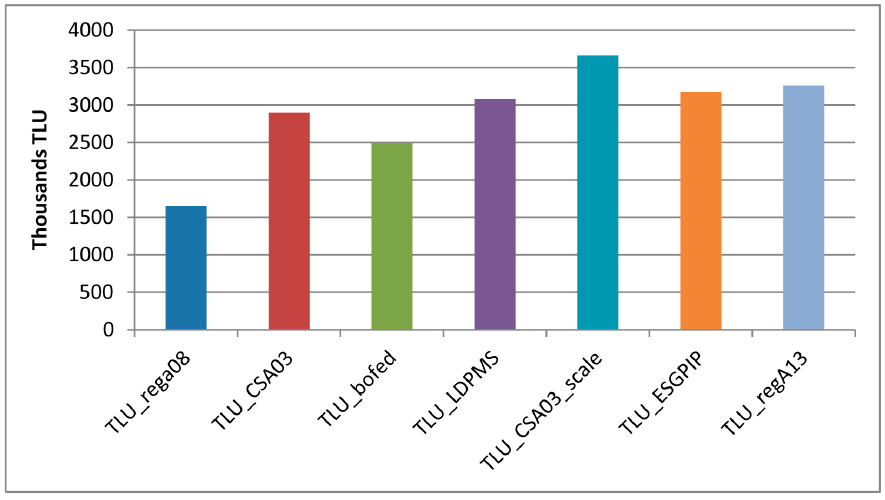
Figure 4. TLU in the Afar by data source. Table 6. Sources of livestock numbers in the Afar.